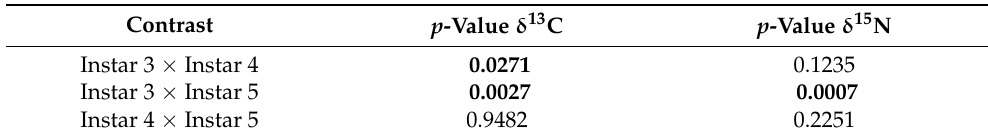
Table 3. Tukey–Kramer post-hoc contrasts, means, and p -values for analyses of δ 13 C and δ 15 N data for 3rd, 4th, and 5th instar larvae from Site 3. p -values indicating statistically significant differences are highlighted in bold text.